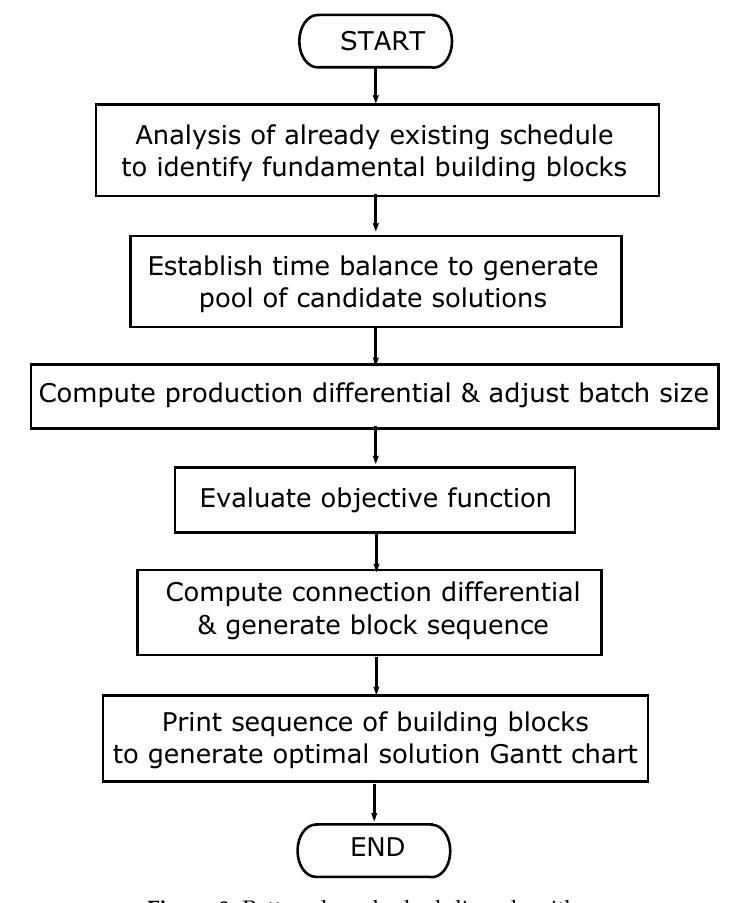
Figure 9. Pattern-based scheduling